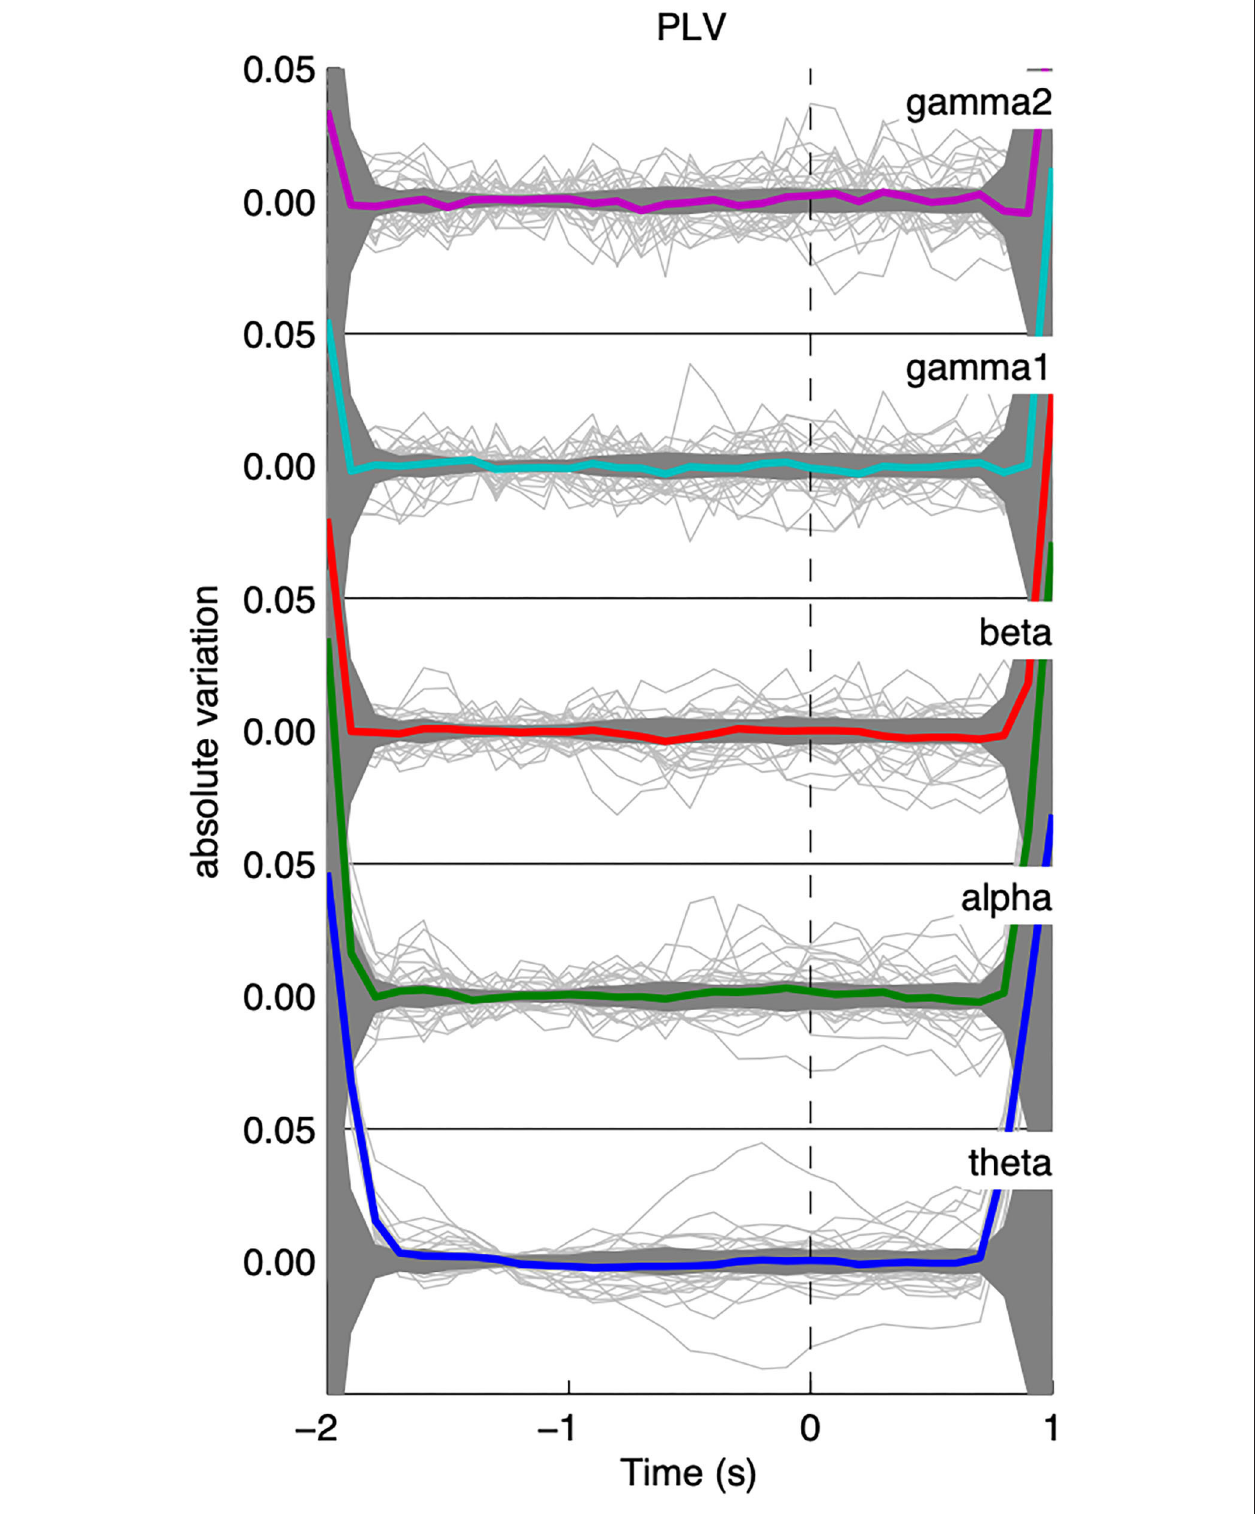
FIGURE 4 | Average time course of the shuffled iEEG functional connectivity; results were only flat noise and no change in connectivity was observed for all frequency bands.